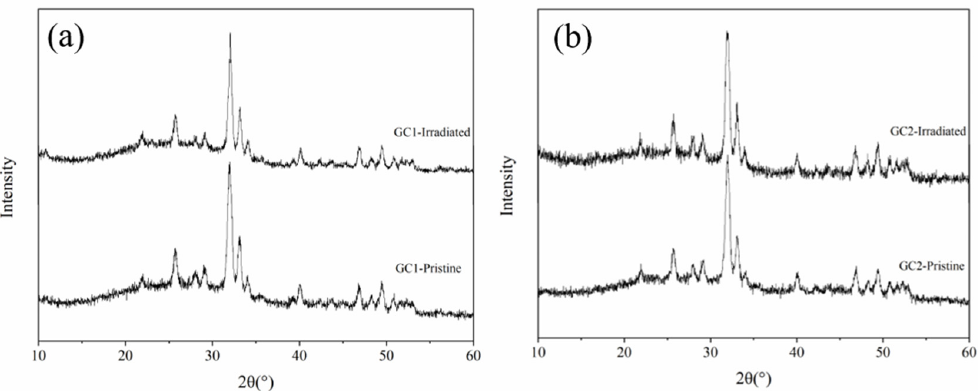
Figure 3. The GIXRD patterns of two samples irradiated by 50 keV He + ion irradiation to a fluence of 2.6 × 1016 He + /cm 2 at 593 K. ( a ) GC1, ( b ) GC2.